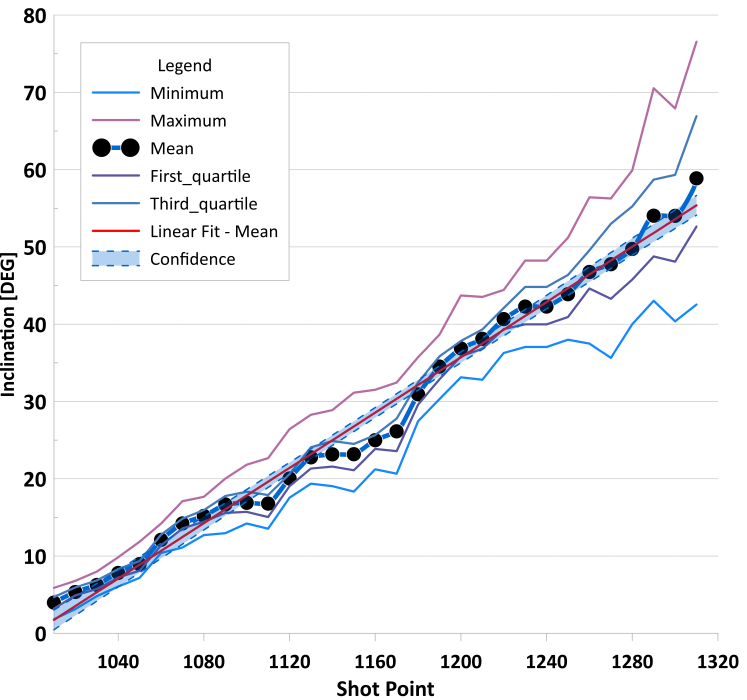
Figure 14. Average P-wave polarization angles for the different shot points along the profile ( black dots ), with trend line ( red ) and basic statistics. Please note that shot point numbers increase with the offset.